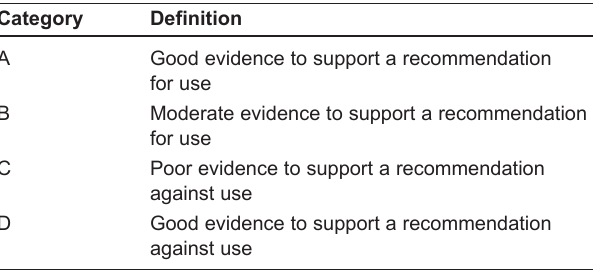
TABLE 1 Categories indicating the strength of the evidence